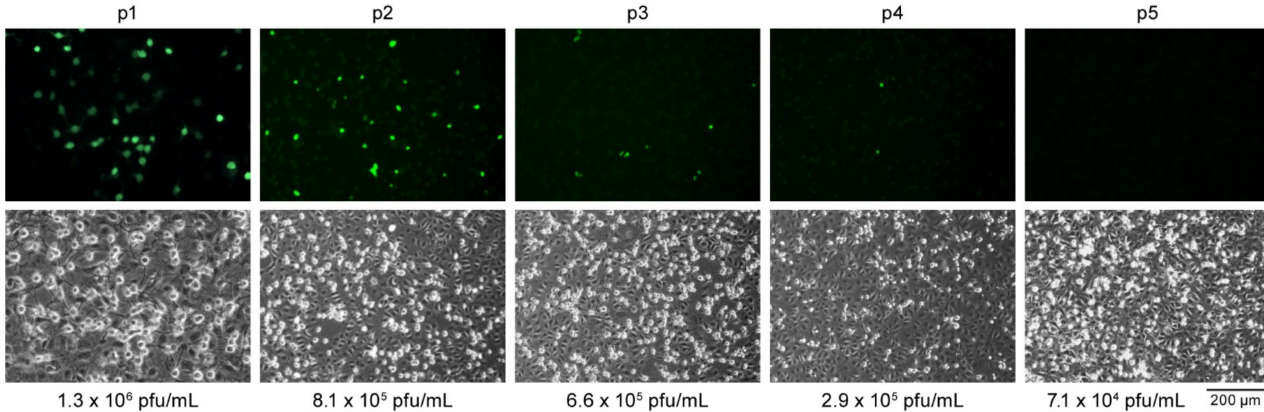
Figure 6. Genetic stability of recombinant wild-type simian hemorrhagic fever virus (SHFV) expressing enhanced green fluorescent protein-expressing (rSHFV-eGFP) in MA-104 cells. rSHFV-eGFP was serially passaged on MA-104 cells. Cells were exposed to rSHFV-eGFP at a multiplicity of infection (MOI) of 1, tissue culture supernatants were collected (Passage 1 [p1]) at 48 h post-exposure, and virus titers were determined by plaque assay. Fresh MA-104 cells were infected with tissue culture supernatants at an MOI of 1. This process was serially repeated through Passage 5 (p5). eGFP expression (green) was measured by epifluorescent microscopy (top row). Cells were imaged by compound microscopy (bottom